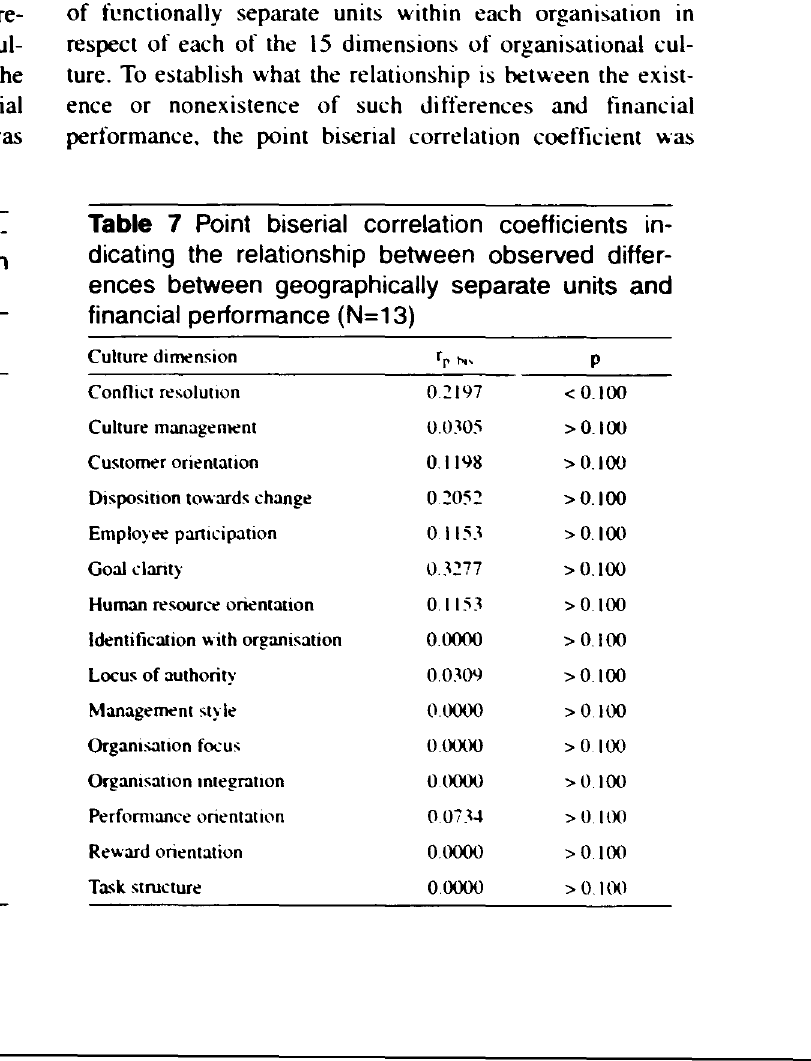
Table 7 Point biserial correlation coefficients